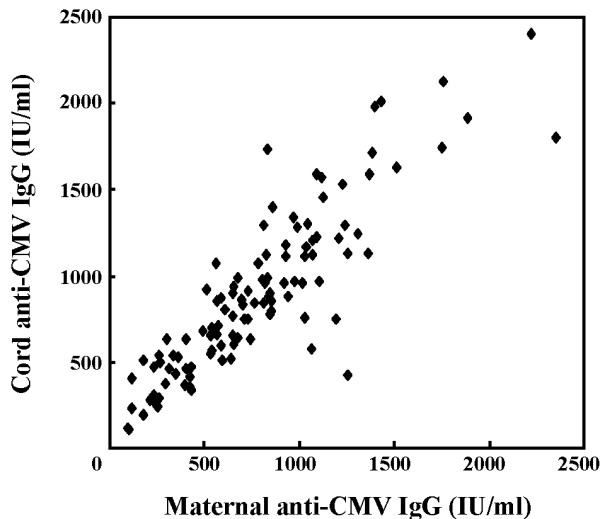
Correlation of transplacentally transferred anti-CMV IgG in infants with the maternal antibody. Anti-CMV IgG level in the cord blood was correlated with that in mothers (linear regression analysis, y = 1.04x + 105.09, r = 0.87, p < 0.001, n = 108).